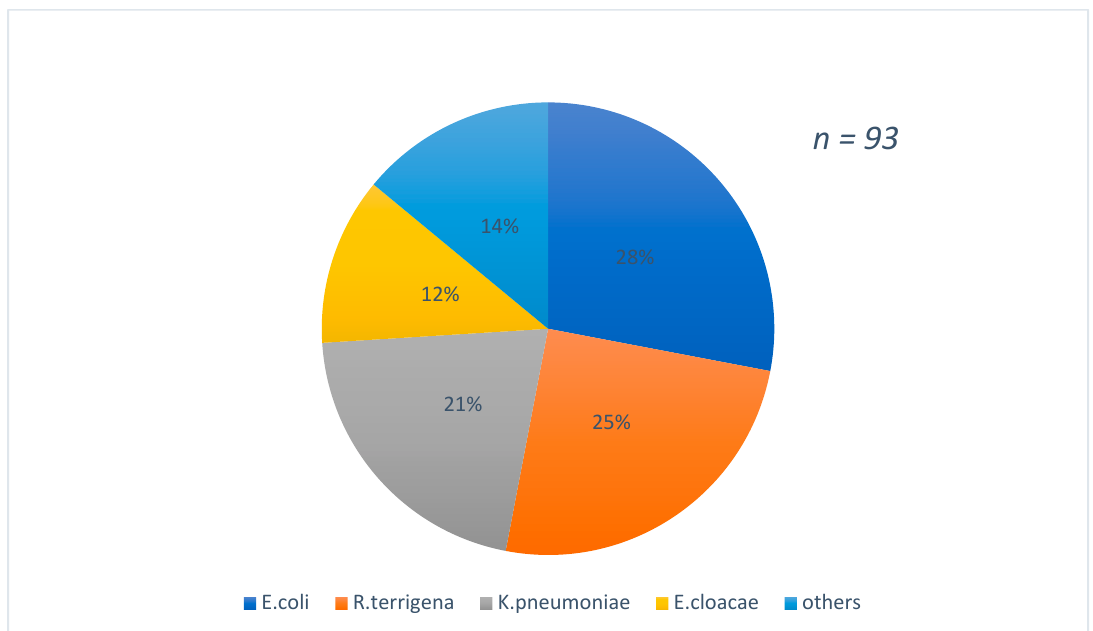
Figure 2. Distribution of strains isolated according to the species found.